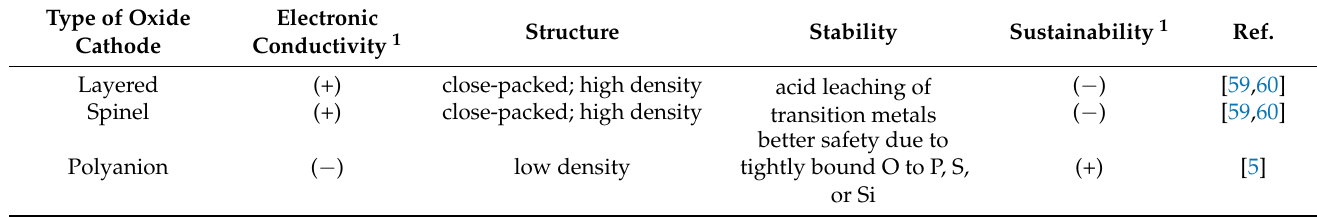
Table 2. Summary of the advantages and disadvantages of different oxide